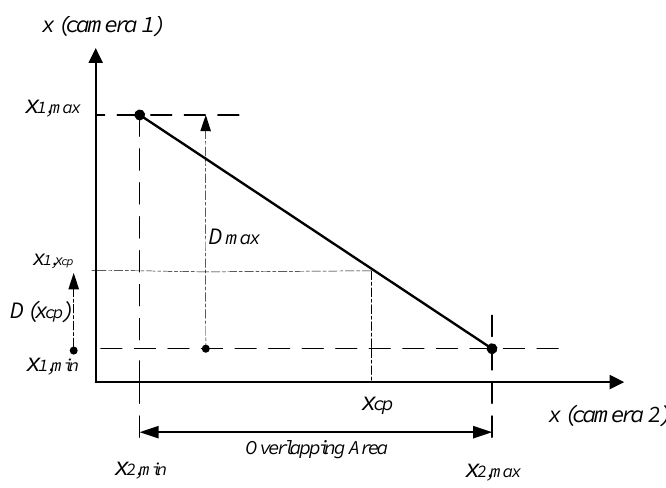
Figure 13. Range D in overlapping